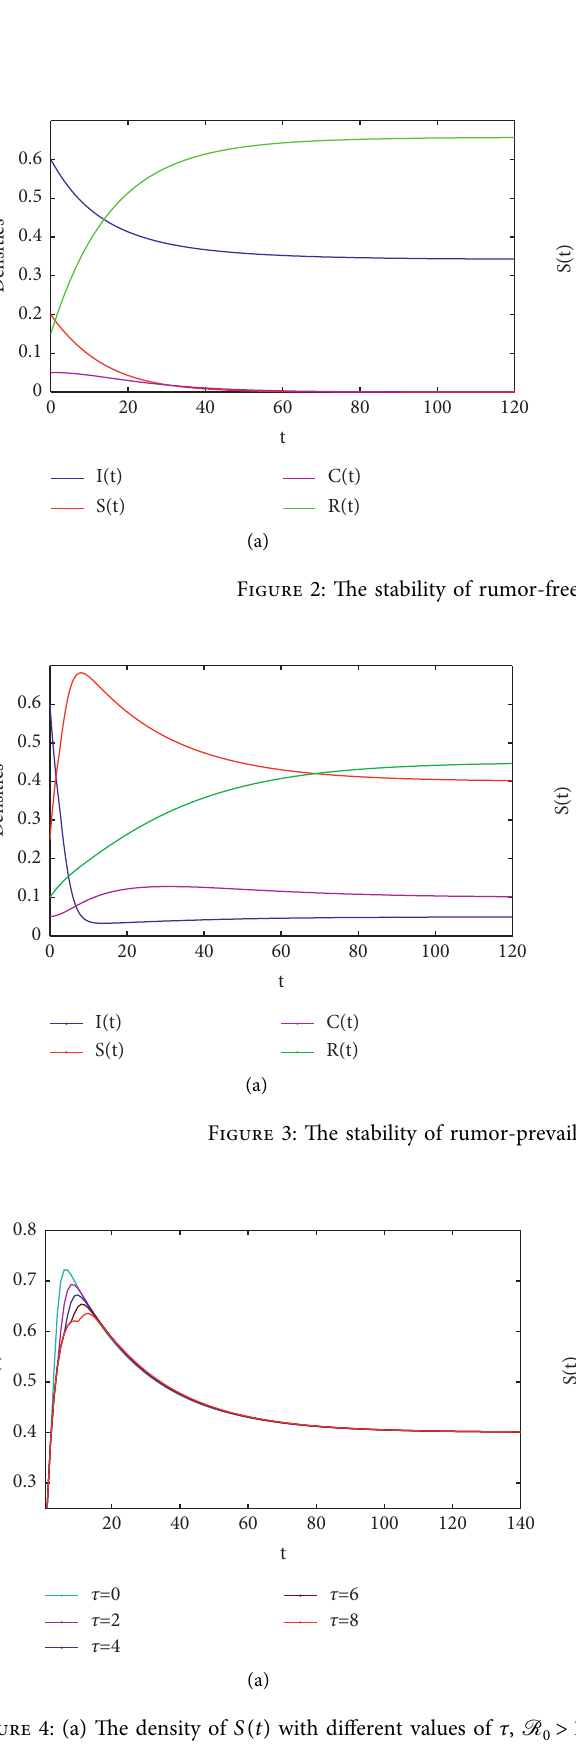
> 1. (b) The density of S ( t ) with different values of α , R 0